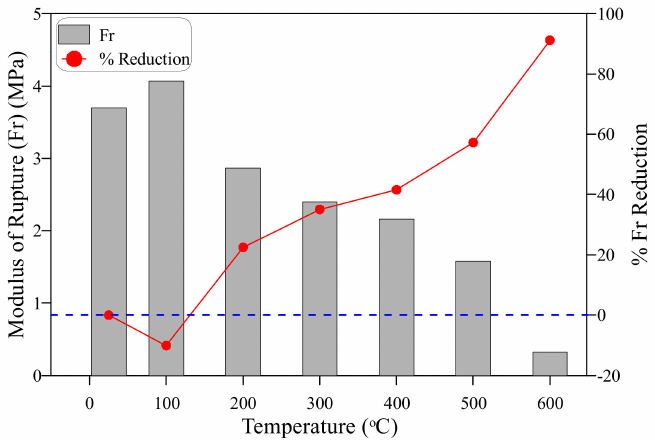
Figure 8. Flexural strength and its percentage reduction at different